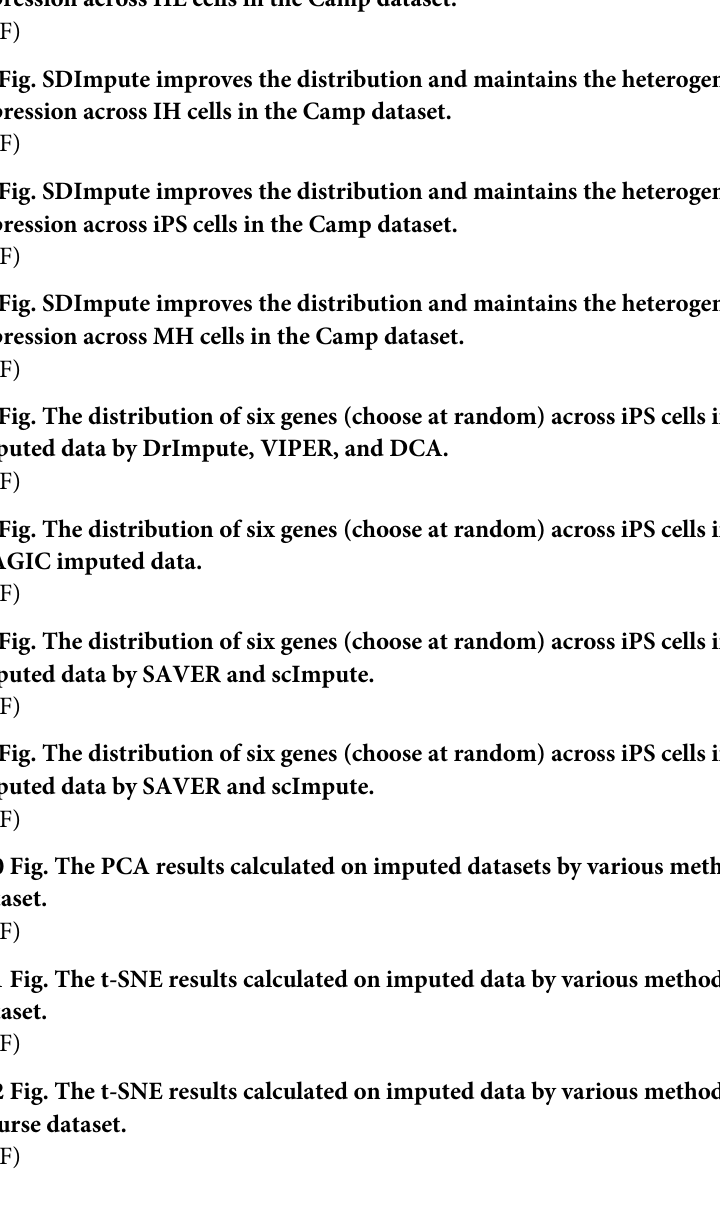
S1 Fig. The workflow figure of SDimpute. (TIF) S2 Fig. SDImpute improves the distribution and maintains the heterogeneity of gene expression across HE cells in the Camp dataset. S3 Fig. SDImpute improves the distribution and maintains the heterogeneity of gene expression across IH cells in the Camp dataset. S4 Fig. SDImpute improves the distribution and maintains the heterogeneity of gene expression across iPS cells in the Camp dataset. S5 Fig. SDImpute improves the distribution and maintains the heterogeneity of gene expression across MH cells in the Camp dataset. S6 Fig. The distribution of six genes (choose at random) across iPS cells in raw data vs imputed data by DrImpute, VIPER, and DCA. S7 Fig. The distribution of six genes (choose at random) across iPS cells in raw data vs MAGIC imputed data. S8 Fig. The distribution of six genes (choose at random) across iPS cells in raw data vs imputed data by SAVER and scImpute. S9 Fig. The distribution of six genes (choose at random) across iPS cells in raw data vs imputed data by SAVER and scImpute. S10 Fig. The PCA results calculated on imputed datasets by various methods in the Camp dataset. S11 Fig. The t-SNE results calculated on imputed data by various methods in the Romanov dataset. S12 Fig. The t-SNE results calculated on imputed data by various methods in the Time Course